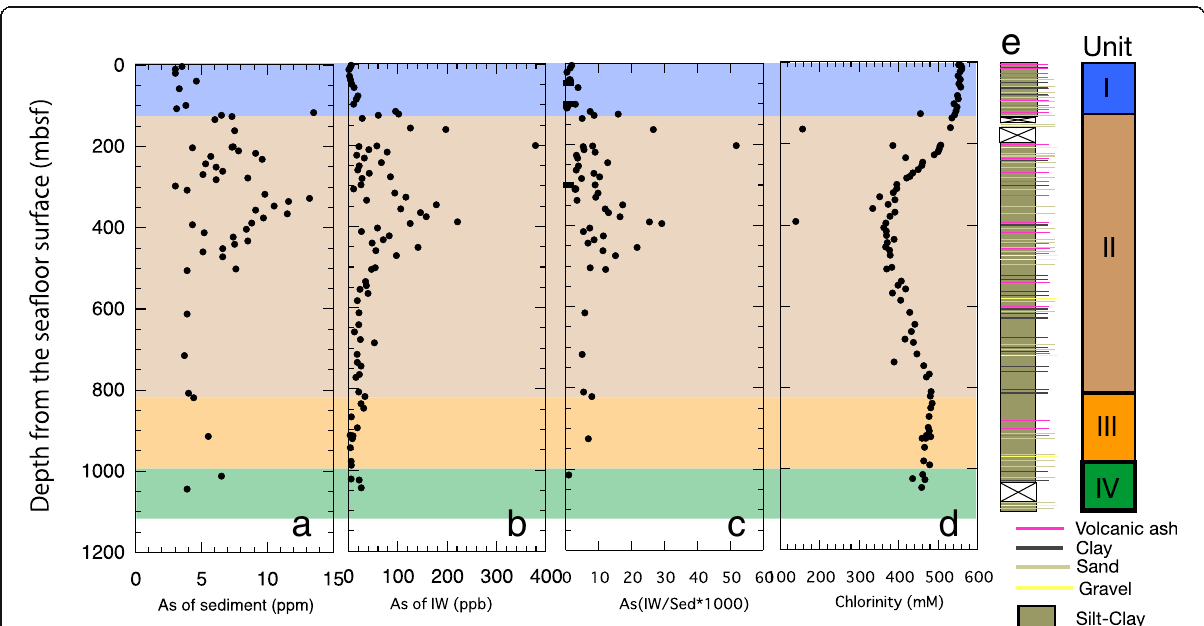
Fig. 2 Arsenic concentrations of sediments (squeezed cakes) ( a ) and interstitial water ( b ), ratio of arsenic concentrations of IW and sediment ( c ), and chlorinity ( d ) of Sites C0002, Kumano Basin, Nankai Trough, in relation to the depth, lithology and its related components ( e ) Lithology was referred to Strasser et al.